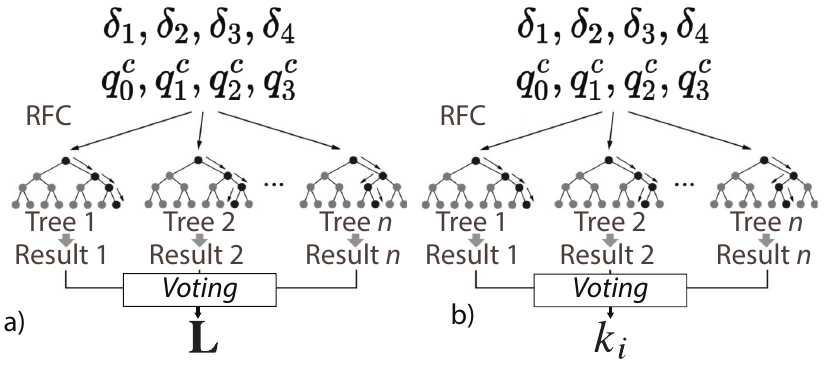
Figure 7. Visualization of the RFC, ( a ) 1st and ( b ) 2nd approach.